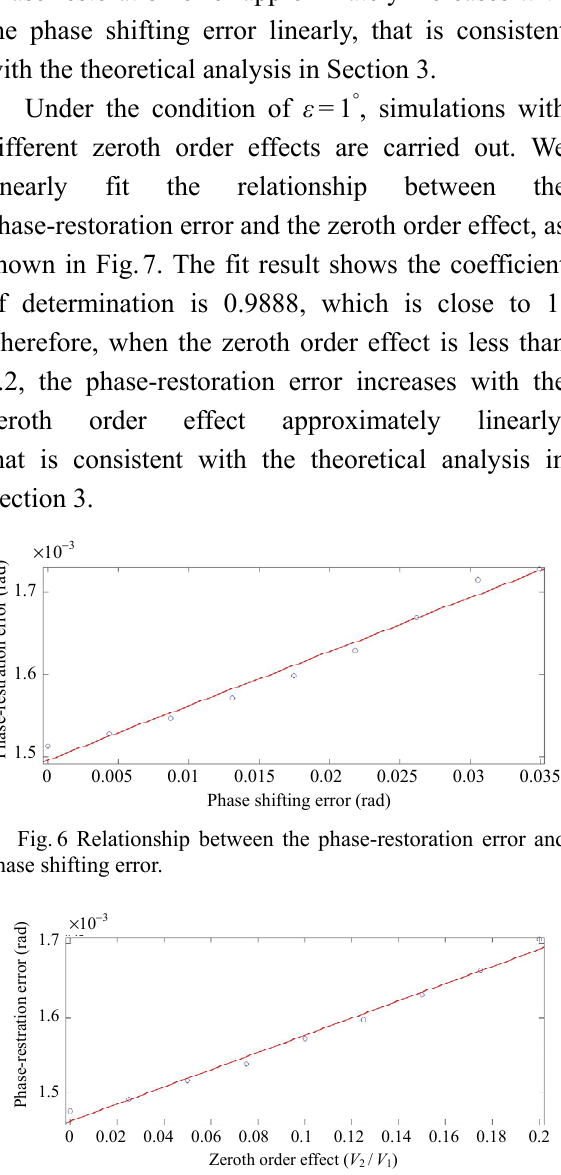
Fig. 7 Relationship between the phase-restoration error and the zeroth order